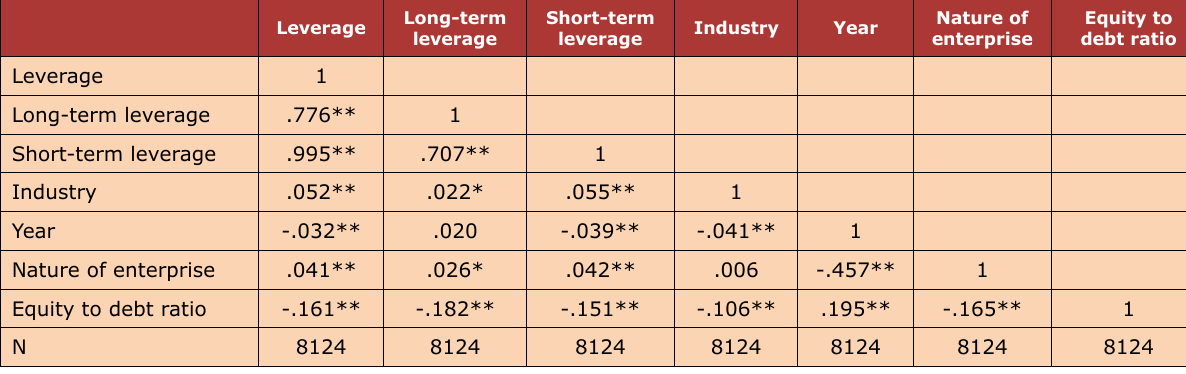
Table 6. Correlations matrix, table of Pearson correlation test for each